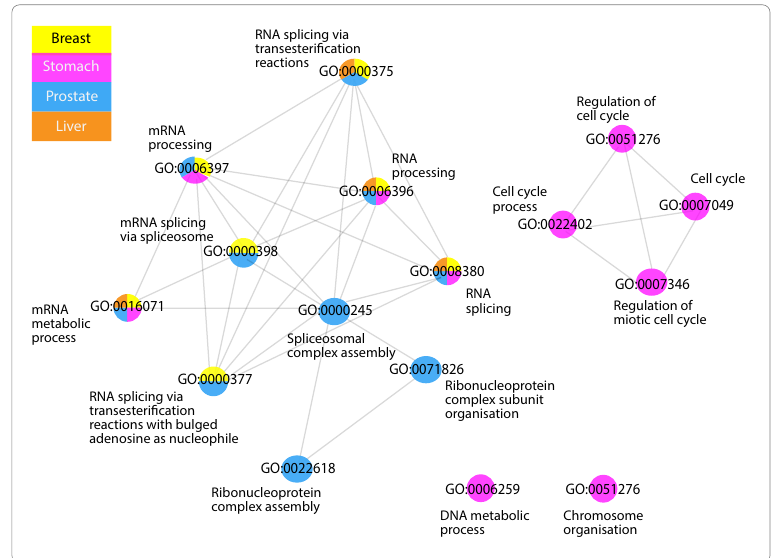
Figure 4. Functional similarity of GO terms associated with mRNAs of positive correlation with lncRNA Divergent. Network visualisation of functional similarity of GO terms enriched by nega- tively correlated mRNAs with lncRNA “Antisense”, across cancers (when applicable, RSS ≥ 0.05). The color(s) of nodes represent the cancer type(s) in which GO term was found to be enriched, orange for liver cancer (LIHC), blue for prostate cancer (PRAD), purple for stomach cancer (STAD) and yellow for thyroid cancer